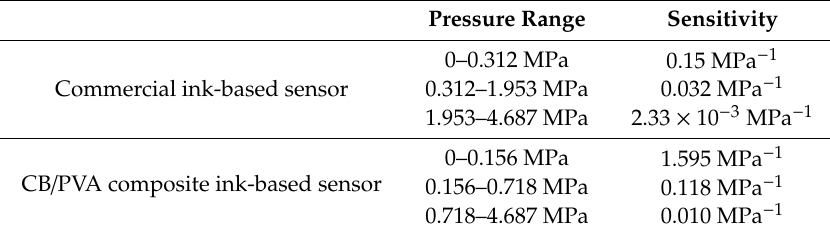
Figure 7. ( a ) Capacitance–pressure characteristics of the sensors. ( b ) Hysteresis behavior. Table 2. Pressure sensitivity of the sensors in di ff erent pressure